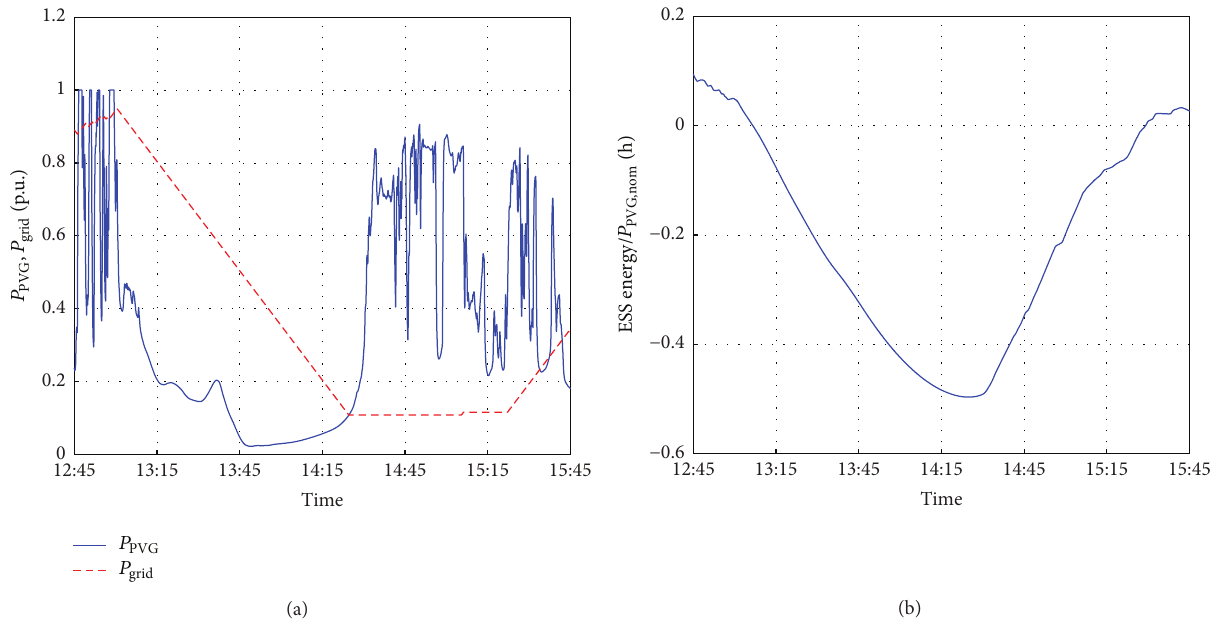
Figure 7: (a) 0.55 MWp PV generator and grid feed-in power and (b) the ESS energy during the formation of the minimum ESS energy with respect to the reference level causing the maximum absolute ESS capacity requirement on 27.06.2012 while complying with RR limit of